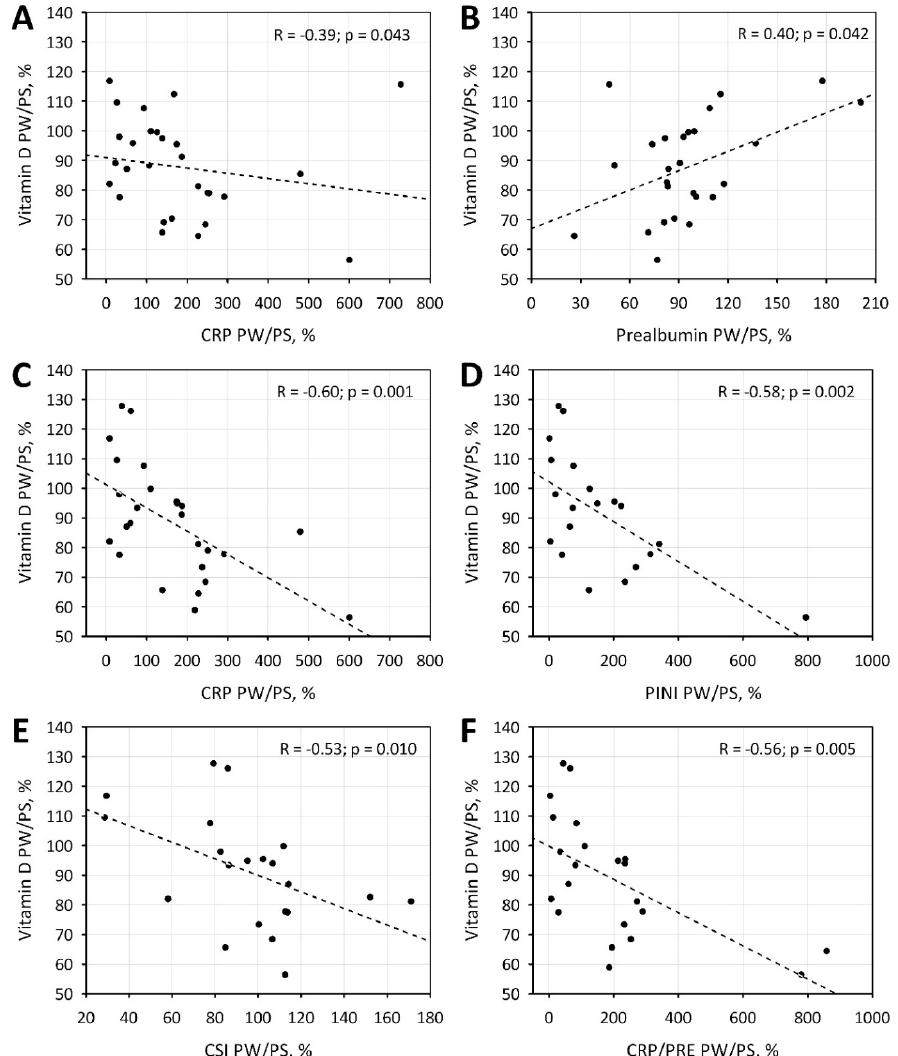
Figure 2. Correlations between seasonal changes in vitamin D and seasonal changes in C-reactive protein (CRP; A ) and prealbumin ( B ) in patients with low initial concentrations of vitamin D (below 25 ng/mL). Correlations between seasonal changes in vitamin D and CRP ( C ), Prognostic Inflammatory and Nutritional Index (PINI; D ), Cancer Serum Index (CSI; E ) and CRP/prealbumin (CRP/PRE; F ) in patients not receiving vitamin D supplementation.